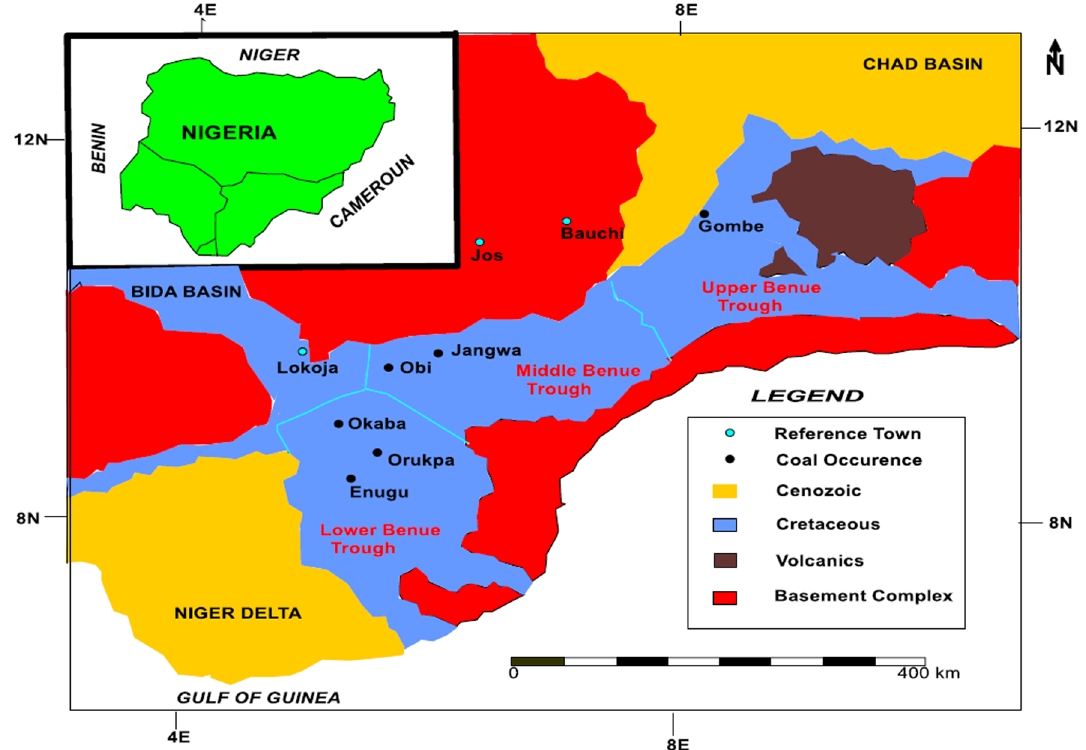
Fig. 1 Geological map indicating the major coal occurrences in the Benue Trough of Nigeria (modified after Obaje et al. 1999, extracted from Akinyemi et al.